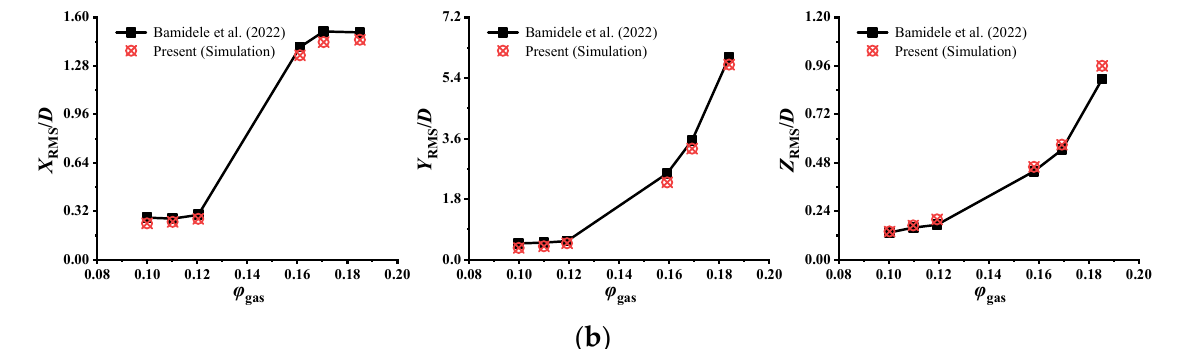
Figure 4. Modal validation test for the gas-liquid flow-induced vibration of an inverted U-shaped jumper, where φ gas is the gas void fraction, X RMS / D , Y RMS / D and Z RMS / D are the root-mean-squared normalized amplitudes in the three directions, and t is the flow time: ( a ) the flow evolution in the inverted U-shaped jumper with v air = 0.51 m/s and v water = 0.46 m/s; the upper part of this figure is from paper; ( b ) the root-mean-squared displacements of the upper right bend in three directions.